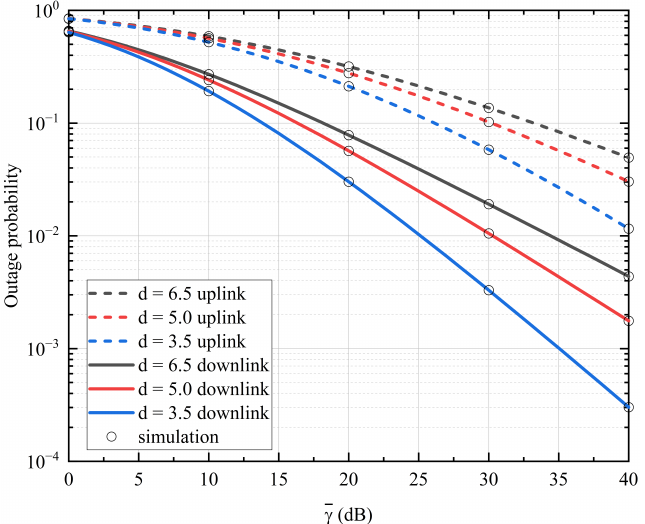
Figure 4. Outage probability under different atmospheric turbulence and pointing error when γ th = 0 dB, ξ = 10, N = 10, d = 5.0 km.